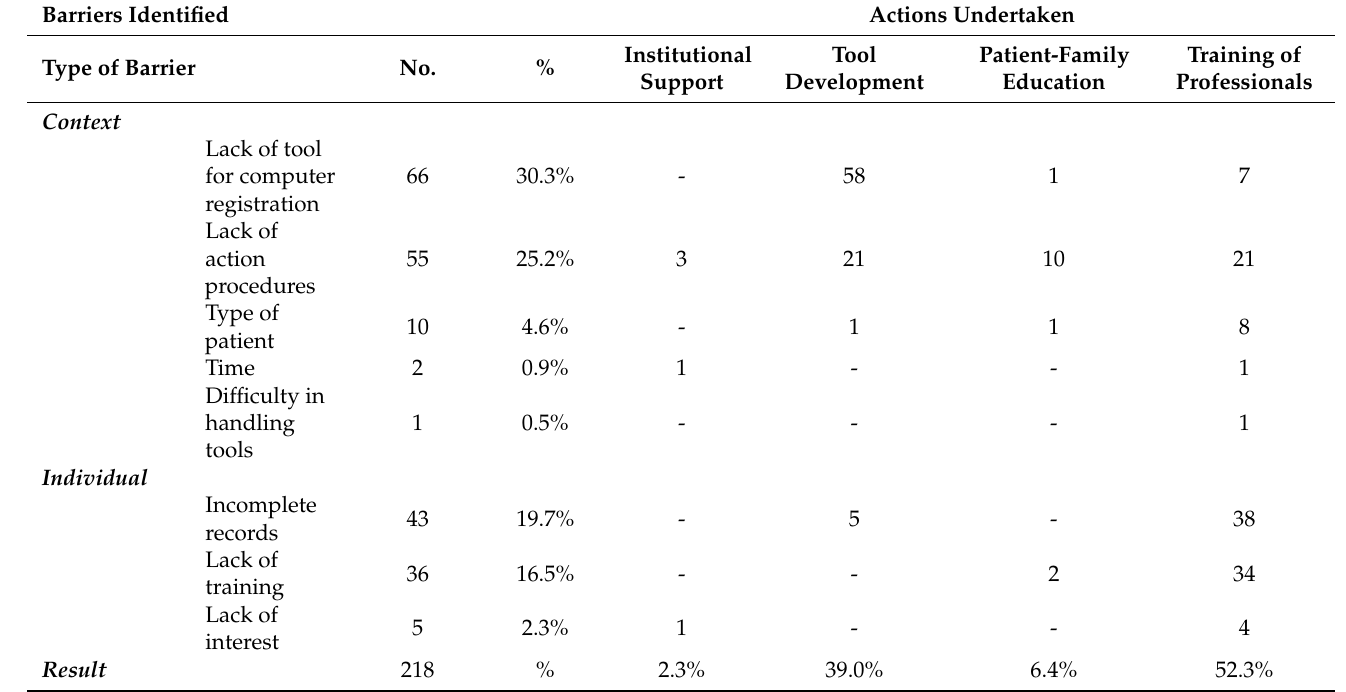
Table 4. Description of the barriers identified and actions